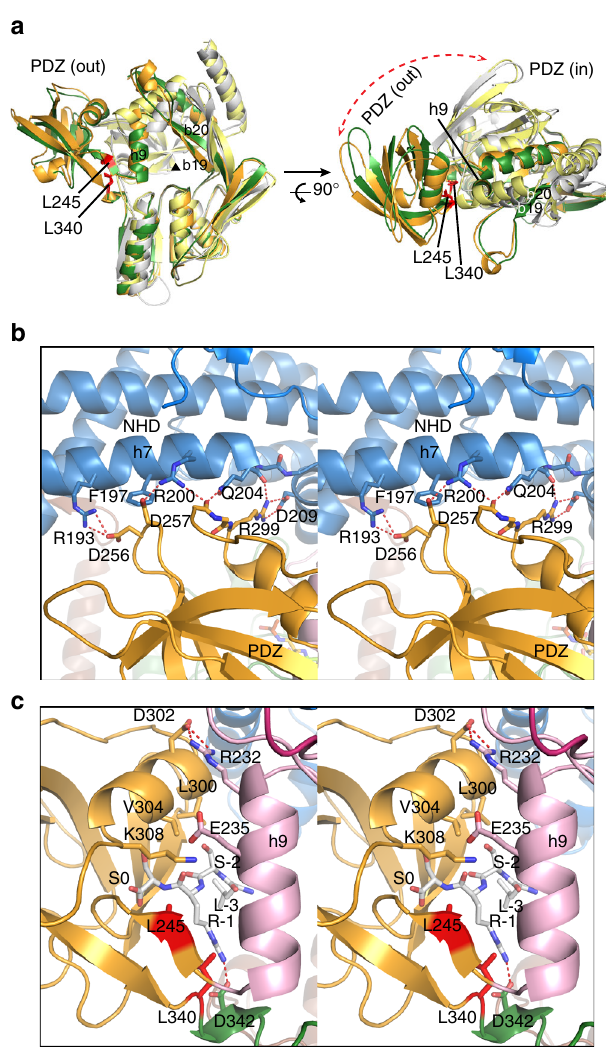
Fig. 8 Large rotational movement of the PDZ domain and sensing of the bound PDZ ligand by the hinge residues in Prc. a Superimposition of the structures of two Prc molecules (chains C and D colored in green and orange, respectively), D1P (gray), and the resting form of CtpB (yellow), which reveals the hinge residues L340 and L245 and suggests a large rigid- body rotation of the PDZ domain of Prc during its proteolytic action. For clarity only the portions of the proteases connecting to the PDZ domains are shown, in two orthogonal views. The substrate passage perpendicular to the page plane is indicated by the black triangle. The r.m.s.d. between aligned Prc and CtpB (sequence identity: 26%) and between aligned Prc and D1P (sequence identity: 25.4%) are 3.09 Å (for 280 residues) and 2.78 Å (for 202 residues), respectively. b Stereo view of the interaction between the PDZ and NHD domains, colored in gold and blue ribbons, respectively, in Prc (chain C). c Stereo view of the hinge residues L245 and L340 interacting with the peptide ligand bound to the PDZ domain of Prc (chain